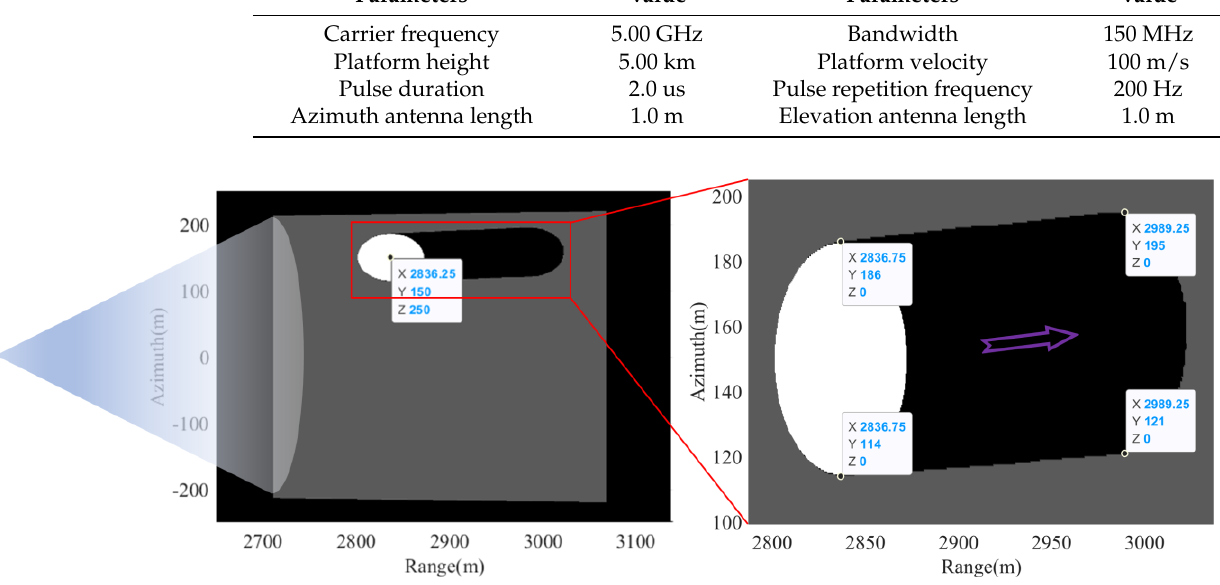
Figure 10. Flowchart of the proposed Topo-BPA for undulating terrain.